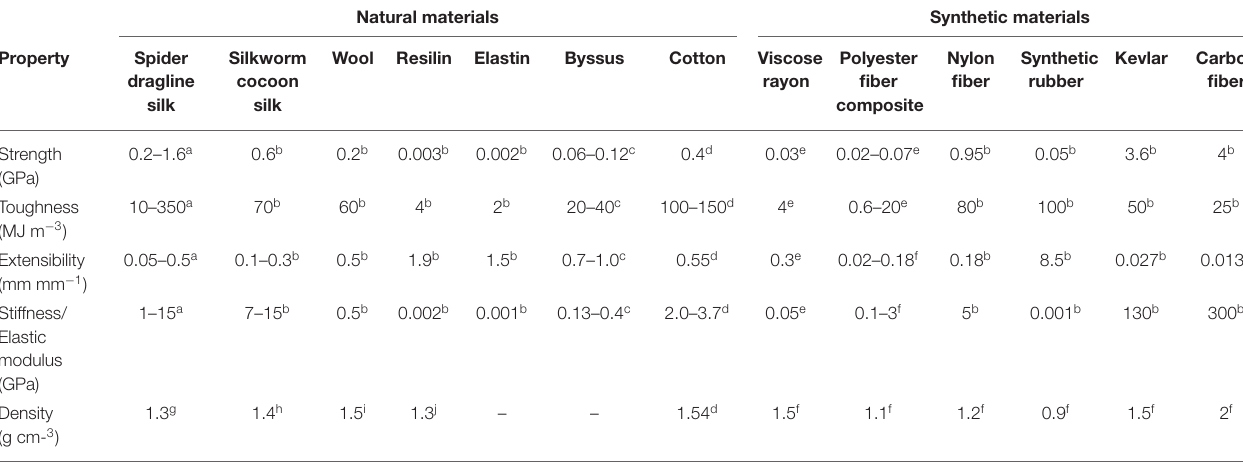
TABLE 1 | A comparison of the various properties of natural and synthetic materials. Natural materials Synthetic materials Property Spider Byssus dragline